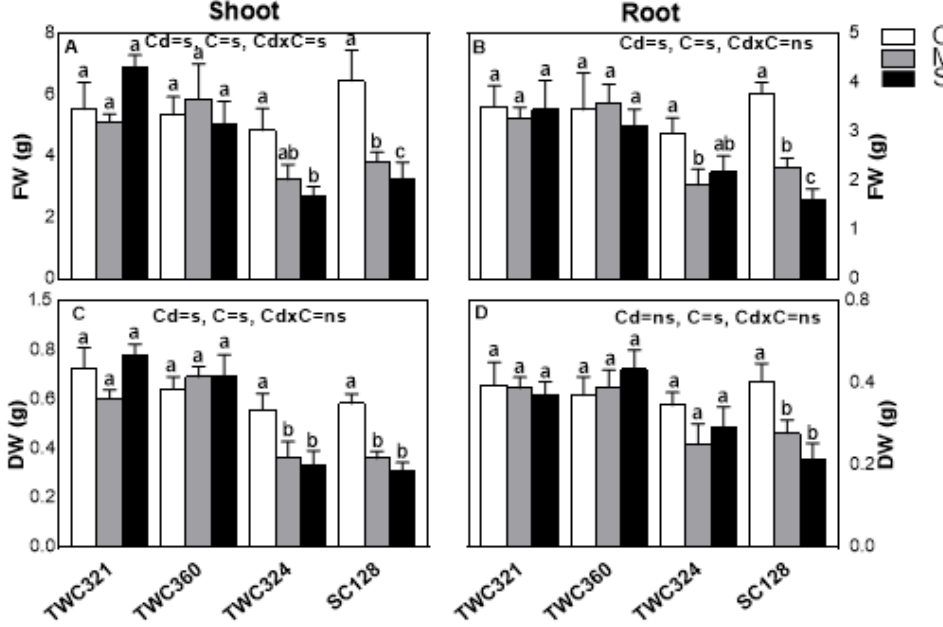
Figure 1. Effect of Cd-stress (C: control, M: mild and S: severe) on ( A ) fresh weight (FW) of shoot, ( B ) fresh weight of root, ( C ) dry weight (DW) of shoot and ( D ) dry weight of root of maize shoot and root respectively. Values are expressed as means ± SE ( n = 5). Bars with at least one similar letter within each cultivar indicate non-significant difference ( p ≤ 0.05). Two-way ANOVA was applied to study the effect of the two factors, Cd-stress (Cd) and cultivars (C), as well as their interaction (Cd × C).